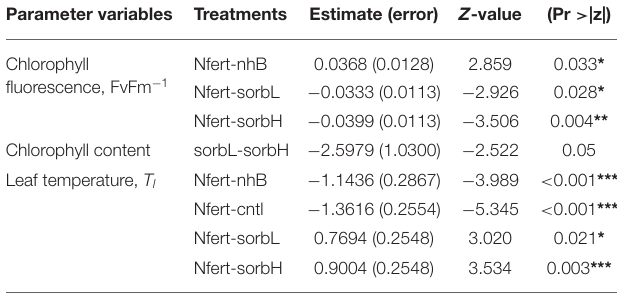
TABLE 2 | Significant pairs from multiple mean comparisons based on Tukey’s honestly significant difference (HSD) test from a linear mixed-effect model fit. Parameter variables Treatments Estimate (error) Z -value